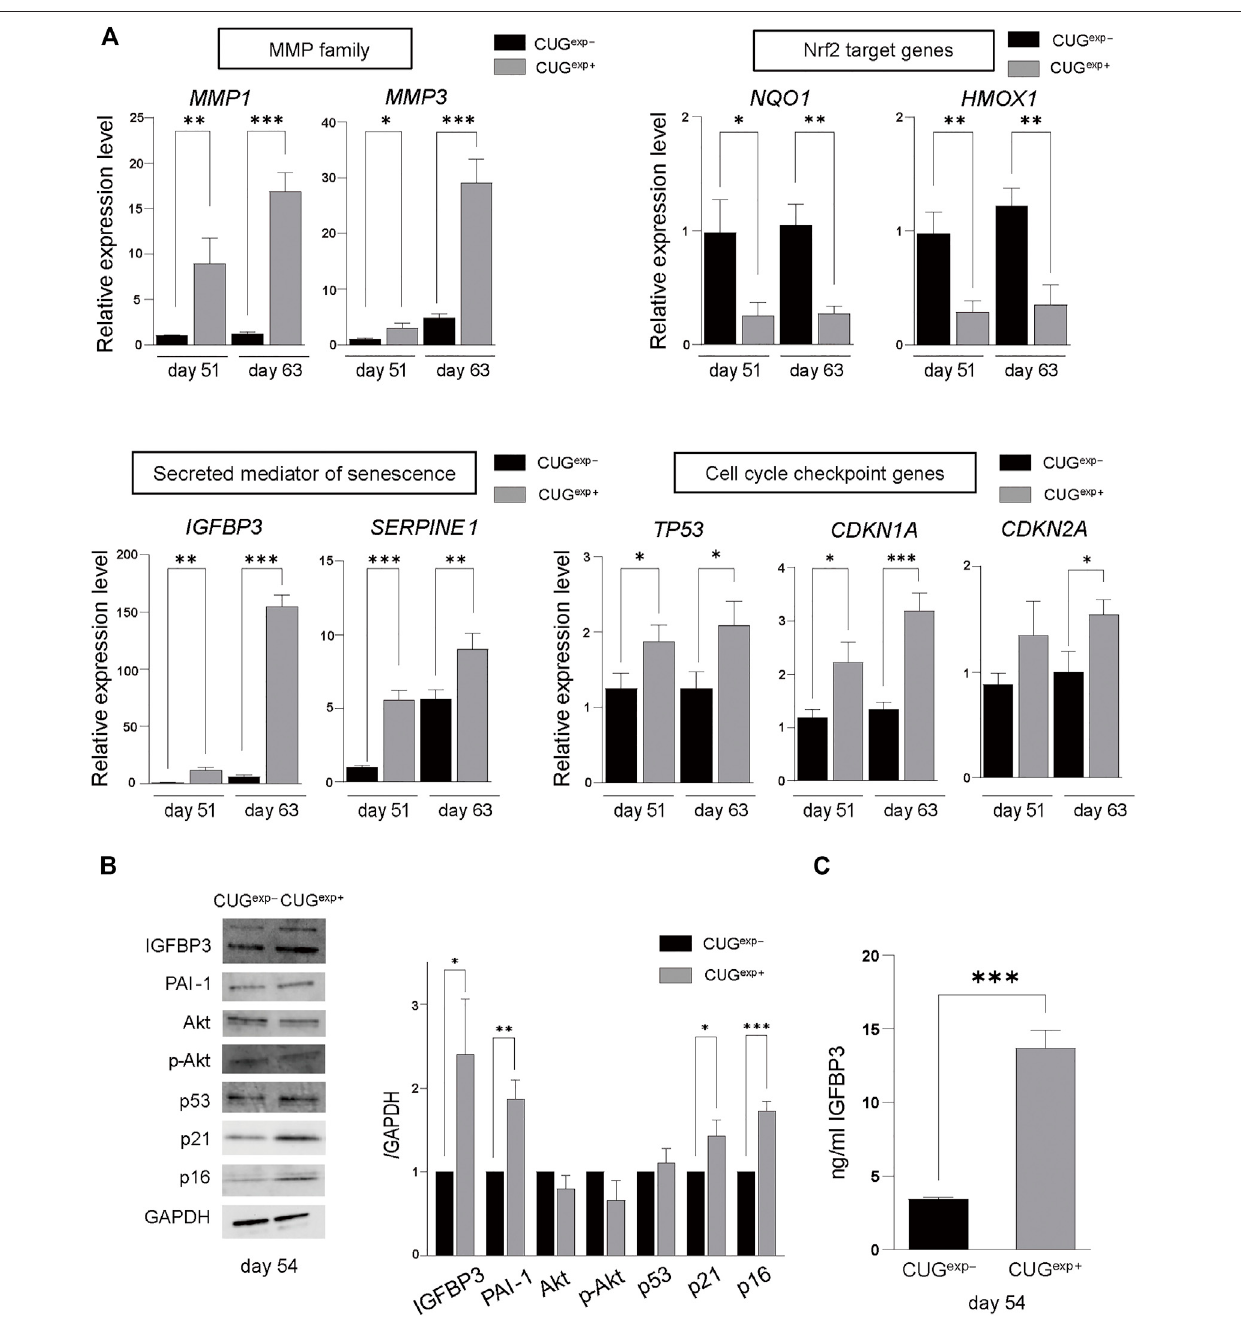
FIGURE 3 | Expanded CUG repeat RNA alters gene and protein expression levels related to cellular senescence. (A) Gene expression levels of MMP family genes ( MMP1 and MMP3 )(topleft),Nrf2targetgenes( NQO1 and HMOX1 )(topright),secretedmediatorsofsenescencegenes( IGFBP3 and SERPINE1 )(bottomleft),andcell cycle checkpoint genes ( TP53 , CDKN1A , and CDKN2A ) (bottom right) determined by qRT-PCR in cells not expressing CUG exp (CUG exp − ) and cells expressing CUG exp (CUG exp+ ) cells at days 51 and 63. Values are presented as means ± SD of three independent experiments. * p < 0.05, ** p < 0.01, and *** p < 0.001. (B) RepresentativeimagesofwesternblotsofIGFBP3,PAI-1,Akt,phospho-Akt(Ser437),p53,p21,andp16proteinsinCUG exp − andCUG exp+ cellsatday54(left).GAPDH was used as the loading control. Bar graph shows quanti fi cation of the immunoblot (right). Values are presented as means ± SD ofthree independent experiments. * p < 0.05, ** p < 0.01, and *** p < 0.001. (C) IGFBP3 levels in the culture medium of CUG exp − and CUG exp+ cells at day 54. Values are presented as means ± SD of three independent experiments. *** p <